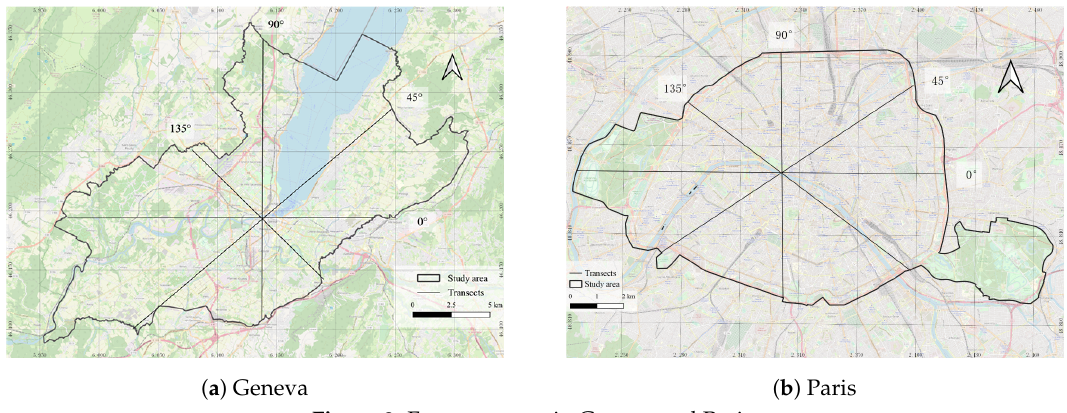
Figure 3. Four transects in Geneva and